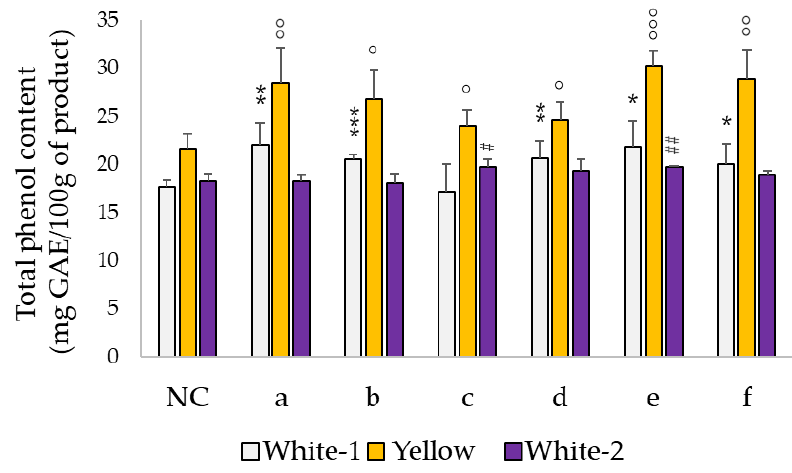
Figure 1. Total phenol content determination of the three corn by-products. Absorbance at 740 nm was measured, and values were expressed as GAE (mg GAE/100 mg of product). The means of 3 experiments were compared with the specific control values (3 replicates for each experiment). Statistic symbol legend: *, ◦ , and # are for white-1 , yellow , and white-2 corn by-products, respectively. (***, ◦◦◦ p < 0.001, **, ◦◦ , ## p < 0.01, *, ◦ , # p < 0.05).